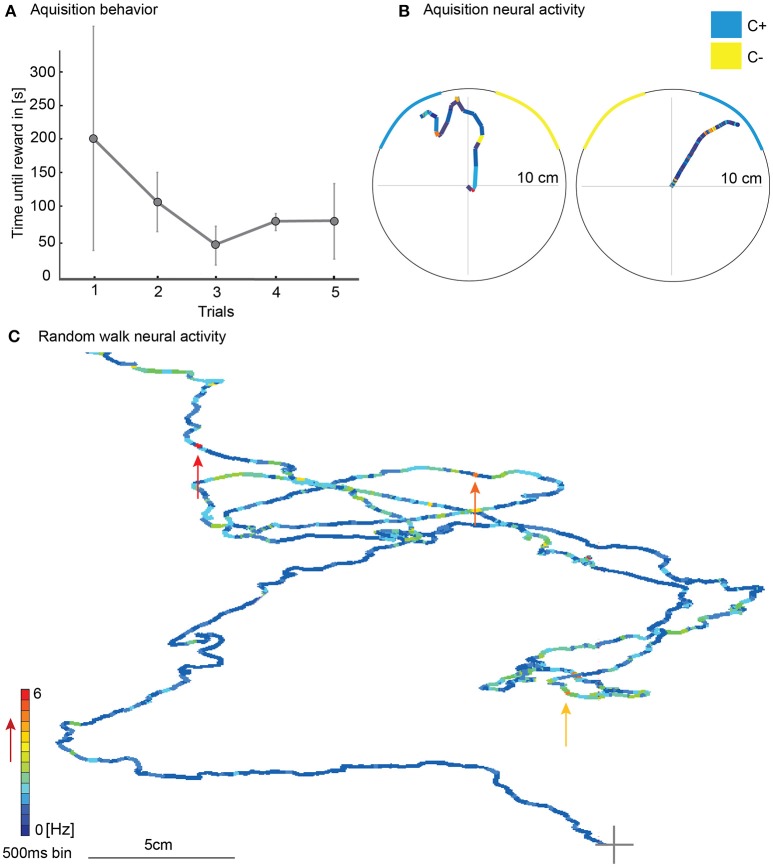
Walking behavior in the virtual environment during learning with simultaneously recorded single unit activity of a mushroom body extrinsic neuron. (A) The time until the animal reached the reward decreased during the five acquisition trials although not statistically significantly [rmANOVA, N = 3, F(4, 8) = 0.61, p = 0.66]. (B) Here the animal walked toward the blue stripe and was rewarded when it reached the rewarding site. The neuronal activity of one responding unit is plotted in false color on top of the walking trajectory. The duration of one colored bin equals 500 ms. The warmer the color, the higher the activity of the unit (see false color scale in C). In two approaches, the activity changed when the animal walked toward the blue stripe shortly before it was rewarded. (C) Example for one single unit activity in Hz plotted on the walking trajectory in a scenario without colored stripes. Single unit activity varied over the course of the walk without any indication of site or place preference. Arrows indicate unit activity at points of high activity. A gray cross marks beginning of walking trace; Vertical bars indicate standard deviation; Hz, Hertz.